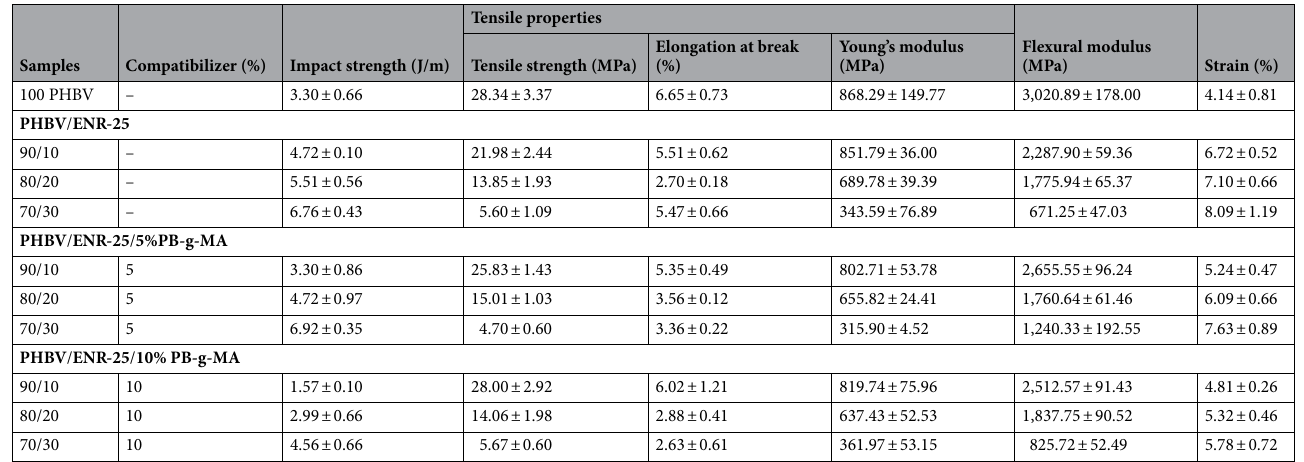
Table 2. Mechanical properties of the PHBV and PHBV/ENR-25